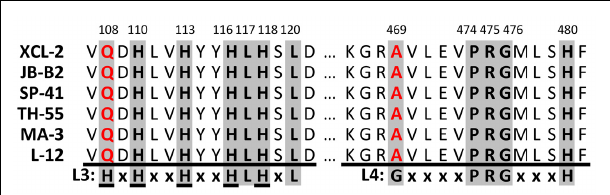
FIGURE 5 | Sequence alignment of cluster II hydrogenases. Shown are the areas of the L3 and L4 motif and the histidine-rich region, respectively. The L3 and L4 motifs are shown in bold below the alignment, amino acids from the histidine-rich region are underlined. An x represents any amino acid, a gray background denotes the positions of conserved amino acids whereas amino acids marked in red indicate differences to the conserved motifs. Amino acid numbering is according to